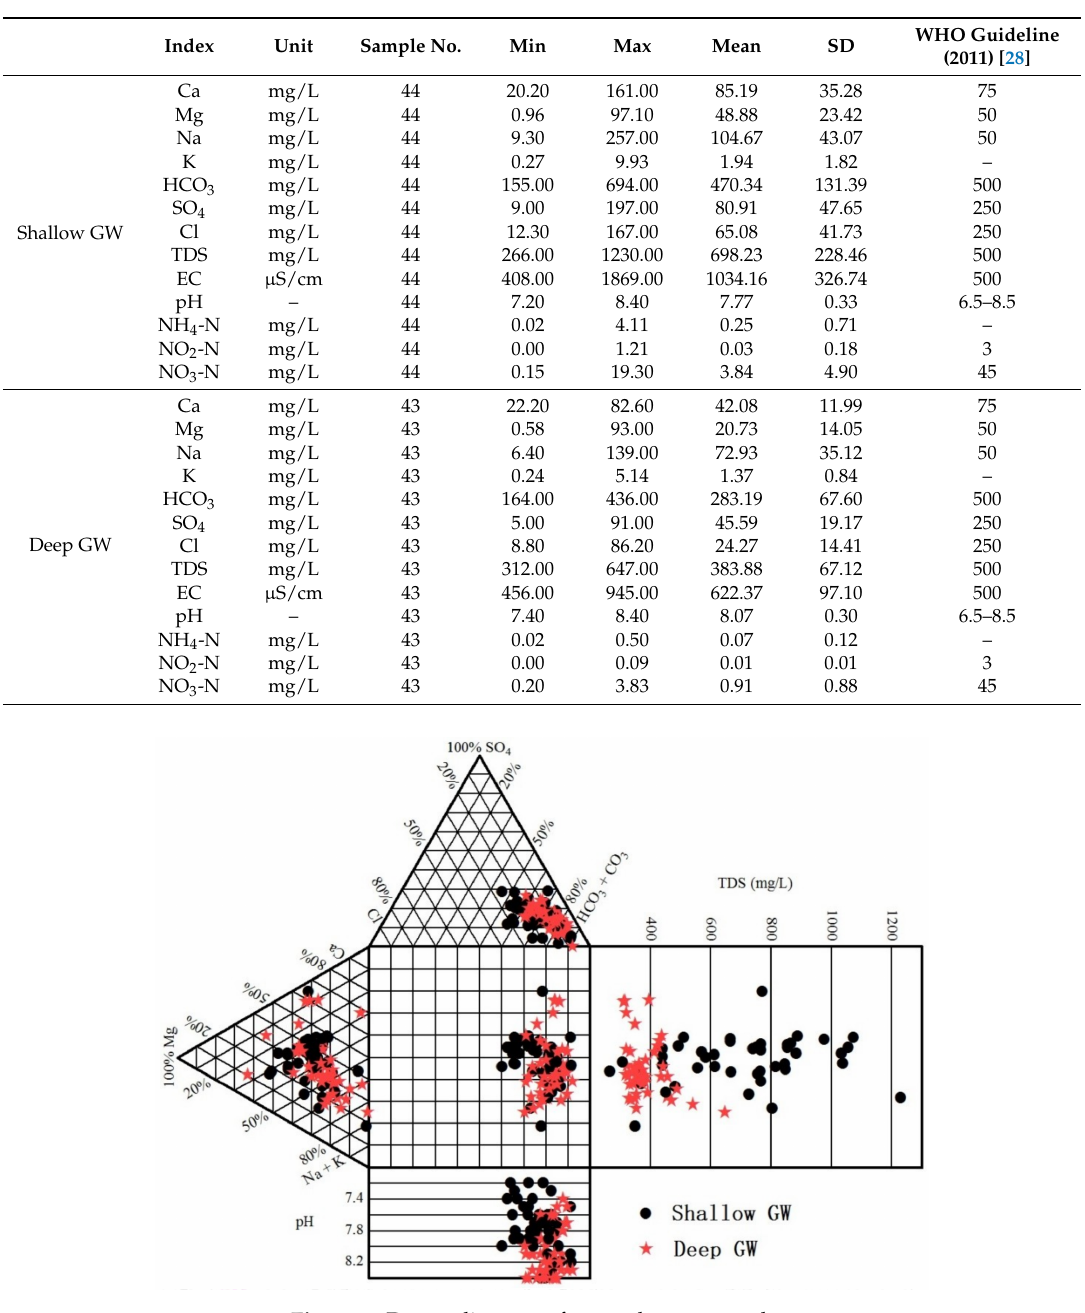
Table 1. Statistical analysis of groundwater samples.